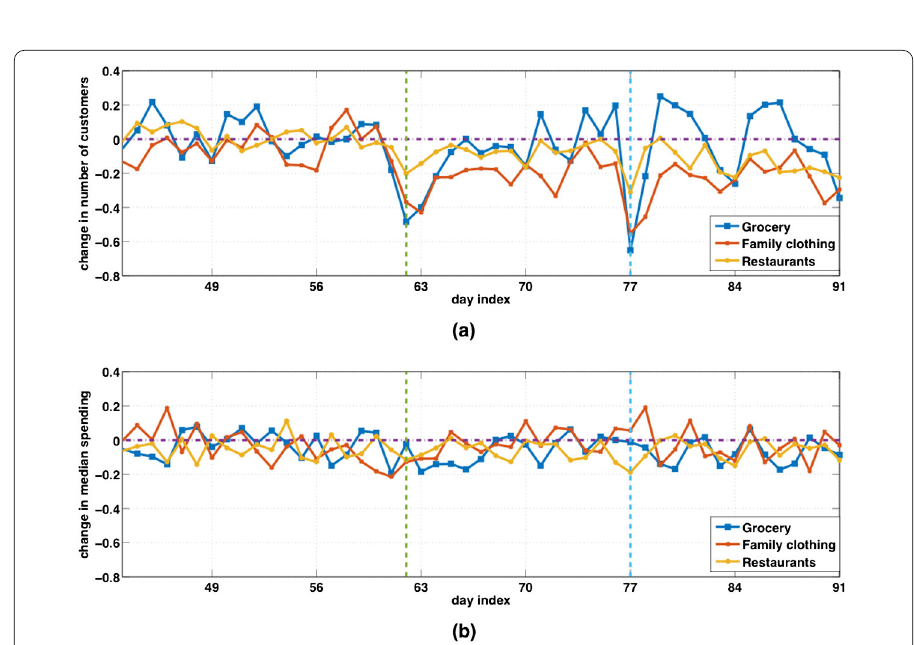
Figure 9 The impact of a series of protest events averaged over all neighborhoods for grocery stores (blue), family clothing stores (red) and restaurants (orange): ( a ) number of customers; ( b ) median spending. The dash-dot purple line indicates zero change, and the dashed green and cyan lines indicate Day 62 and Day 77,